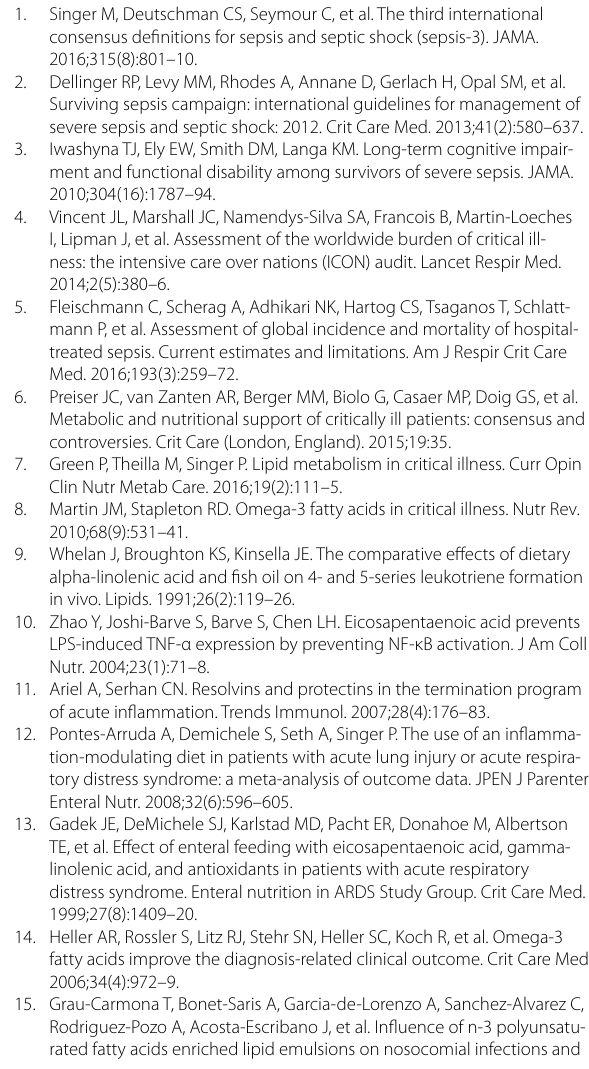
Table S4. Contents of Brand-name Parenteral Formulations. Table S5. Contents of Brand-name Enteral Formulations. Figure S1. Subgroup Analysis for Mortality Outcome. Table S6. Sensitivity Analyses for Mortality Outcome. Table S7. Sensitivity Analyses for ICU Length of Stay Outcome. Table S8. Sensitivity Analyses for Duration of Mechanical Ventilation Out- come. Figure S2. Funnel Plot for Mortality Outcome. Figure S3. Funnel Plot for ICU Length of Stay Outcome. Table S9. PRISMA